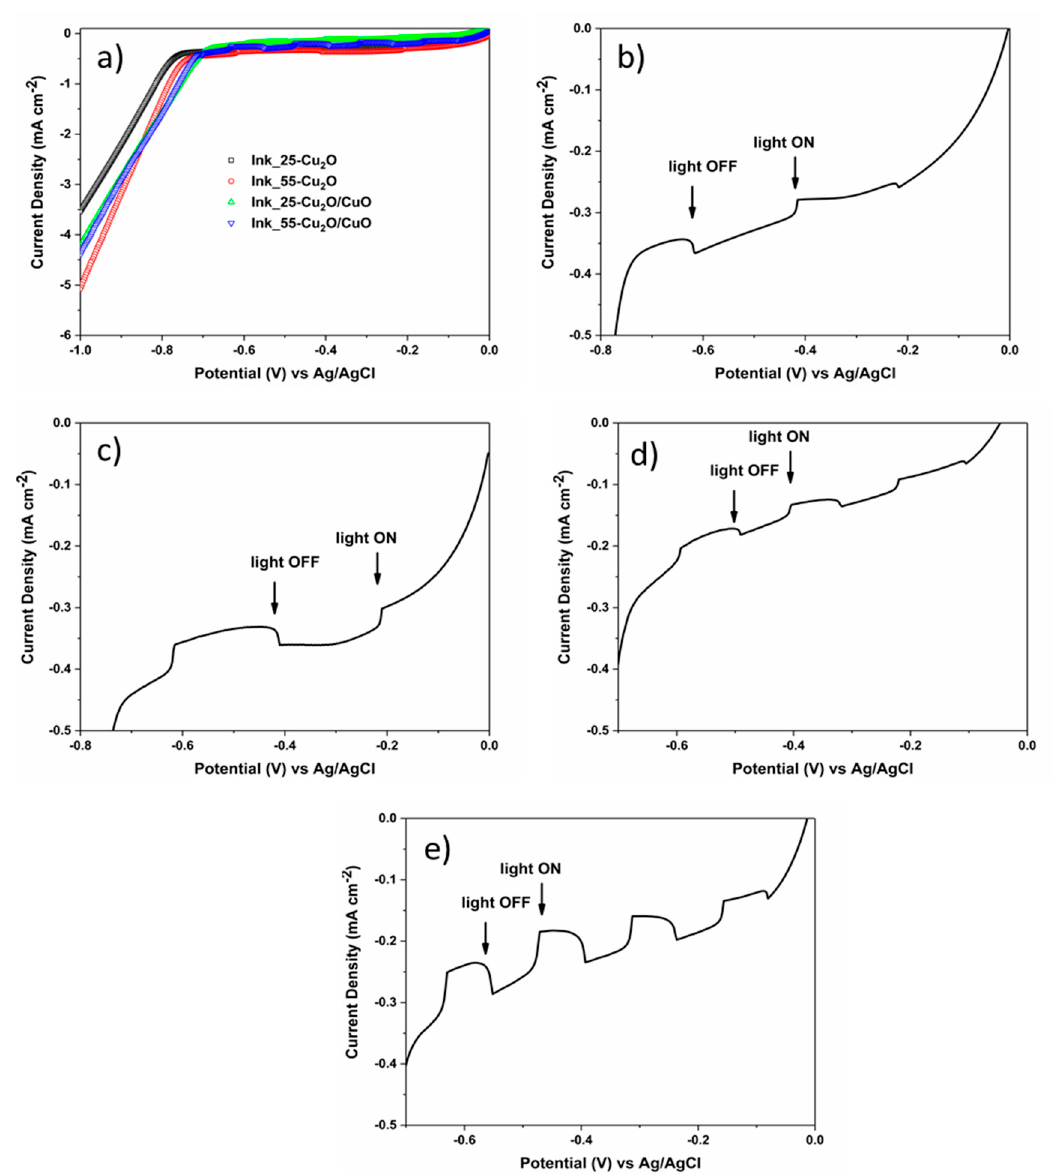
Figure 10. ( a ) Linear sweep voltammetry in light/dark conditions in a wide potential range, ( b ) magnification in the low potential range for films based on ink_25–Cu 2 O, ( c ) ink_55–Cu 2 O, ( d ) ink_25–Cu 2 O/CuO, and ( e ) ink_55–Cu 2 O/CuO.